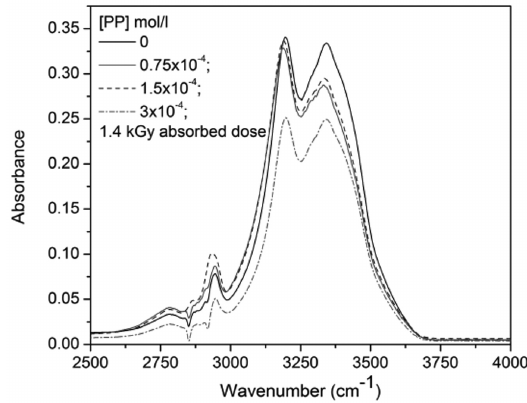
Figure 6. FTIR spectra of samples obtained at 1.4 kGy in range of 2000-4000 cm -1